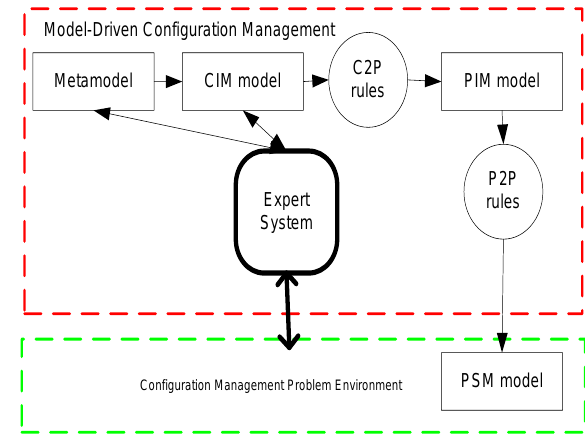
Fig. 1. Conception of model-based configuration